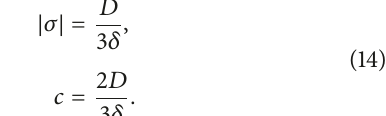
Figure 3: Representation of plane 𝑧 = −2 splitting the prolate spheroid into two TPSs, to demonstrate the validity of (8), shown in this